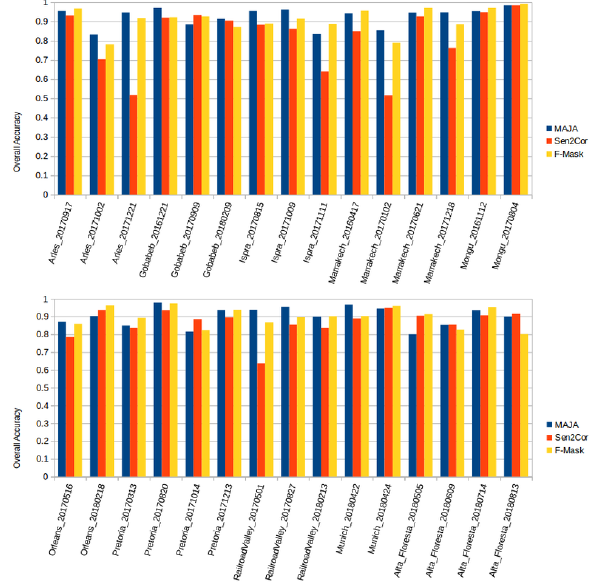
Figure 2. Validation of cloud masks for 3 operational methods, MAJA, Sen2Cor and FMask for 30 images from 10